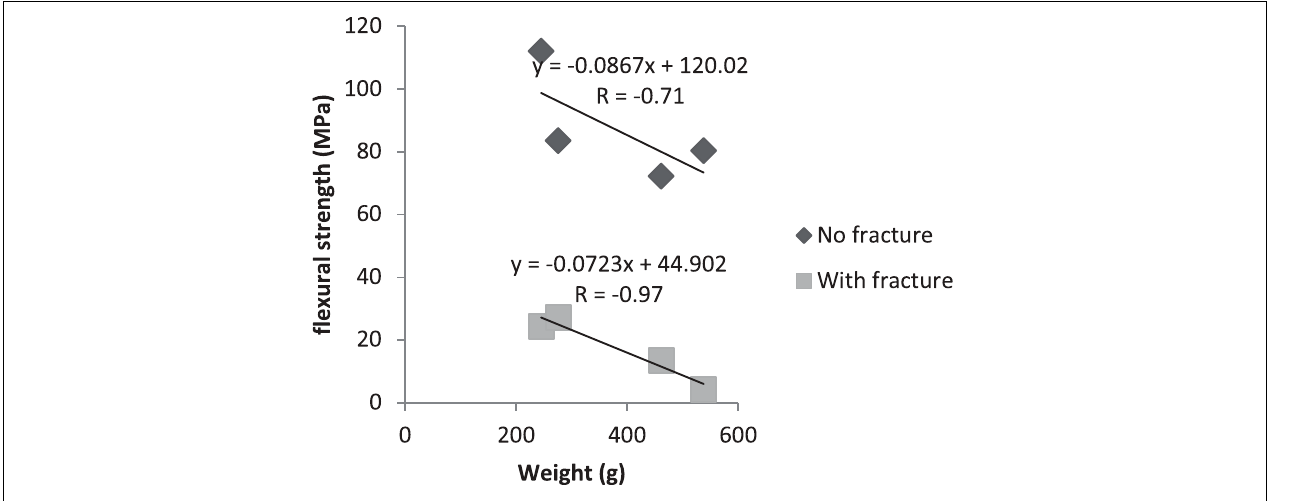
FIGURE 3 | Person’s correlation test between weight and flexural strength, with and without fracture.